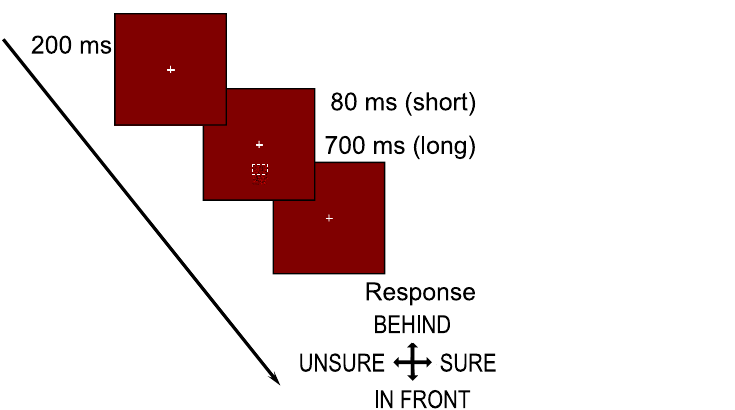
Fig 7. Targets (circle or horizontal edge) were presented below the fixation cross at one of 5 eccentricities (0˚, 3.1˚, 6.2˚, 9.2˚ or 12.2˚) for 80ms. Participants reported the position of the target (compared to the reference) making a response using the up arrow for a ‘further way’ or down arrow for a ‘closer’ response. This was immediately followed by a confidence judgment where right arrow was selected for ‘high confidence’, or left arrow for ‘low confidence/